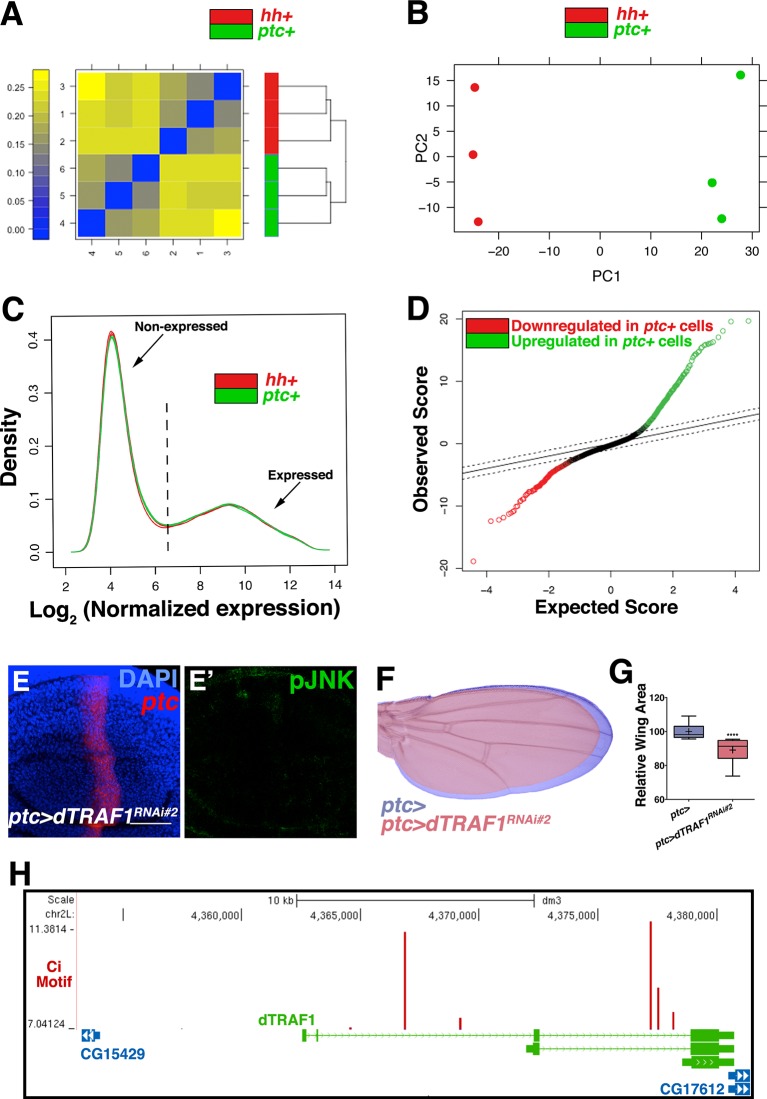
Transcriptional profiling quality control and additional dTRAF1 validation.Related to Figure 5. Quality assessment analyses were conducted with post-normalized data. (A) Microarrays cluster by condition, indicating that biological effects are driving variability. (B) Principle components analysis similarly groups biological replicates. Outliers were not detected in (A) or (B). (C) Density plots of the log2 normalized expression in ptc domain (ptc+) or posterior (hh+) samples are very similar in shape and range, further suggesting comparable signal quality between the two arrays. Probe sets with a median log2 normalized expression ≥6.5 in ptc+ samples, hh+ cells, or both, were considered expressed (Supplementary file 1; Materials and methods). This corresponds to 6854 genic probe sets (47.3%). (D) Quantile-quantile plot for the differential expression analysis. Based on a criteria of minimum fold change ≥1.5 and false discovery rate (FDR) ≤0.01, 624 of 6,854 genic probe sets (9.1%) are differentially expressed, with 376 (5.5%) upregulated in ptc+ samples (green) and 248 (3.6%) downregulated in ptc+ samples (red, Supplementary file 2; Materials and methods). The dashed line indicates the tuning parameter, delta, which is chosen according to the specified FDR (≤0.01). Inhibition of dTRAF1 expression by a second RNAi line also abolishes pJNK staining (E, ptc>dTRAFRNAi#2, and (F) leads to a smaller adult wing (red) compared to control (blue). (G) Quantification of adult wing size. (H) Multiple Ci binding sites (red lines) are identified within the dTRAF1 gene region (green). Height of red line indicates significance of the binding site. Boxes indicate exons, and arrowed lines indicate introns in the direction of transcription. For box plot, whiskers represent maximum and minimum values. ****=p<0.0001. Bar: 50 um.